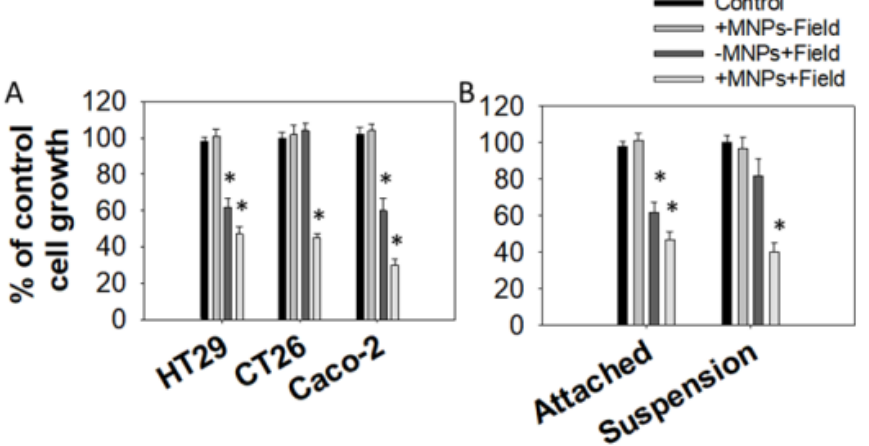
Figure 1. Effect of magnetomechanical treatment on the growth of colon cancer cells. ( A ) Comparison between different cell lines. ( B ) Comparison between attached and suspended HT29 cells. HT29, CT26, or Caco-2 cells were treated with 100 µ g/mL MNPs and/or exposed to a static magnetic field of 200 mT. Values represent the mean ( n = 3) ± S.D. * Asterisks indicate a statistically significant difference compared to the control (Student’s t -test, p ≤